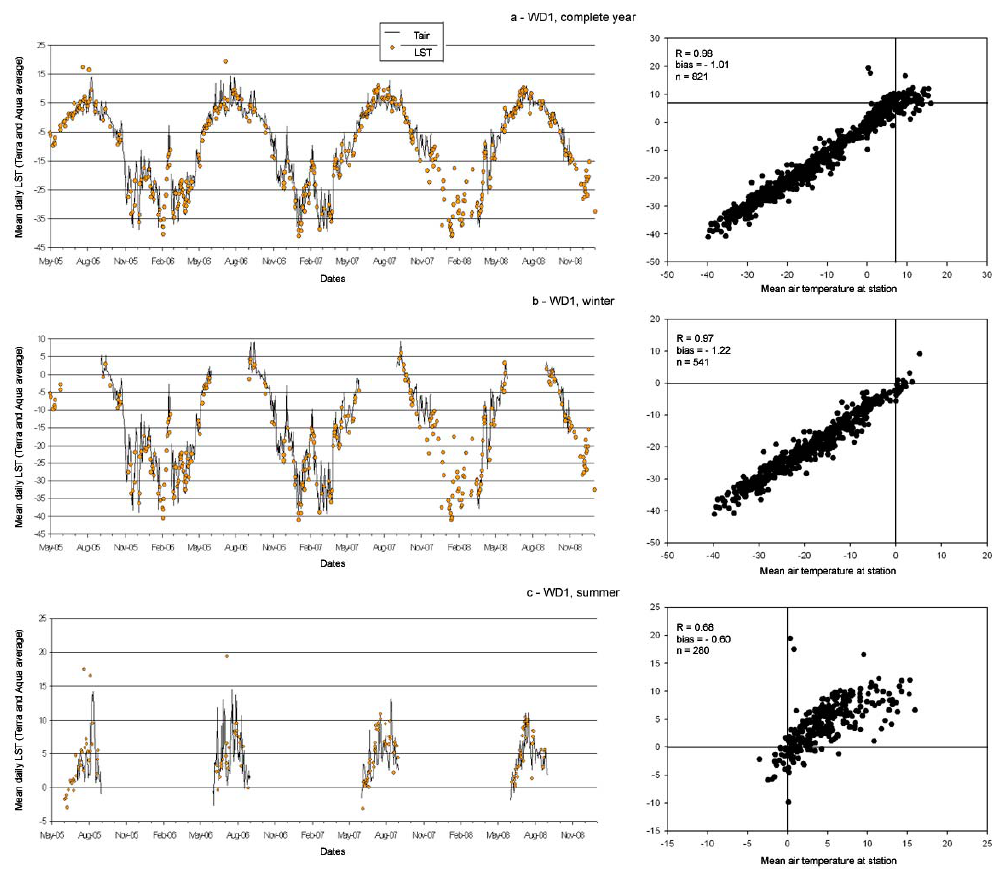
Fig. 5.Comparison between the mean daily LST (combined Day/Night/Terra/Aqua) and mean daily air temperature at West Dock (WD1) for (a) complete year, (b) winter, and (c) summer. On left, LST overlayed on meteorological station measurements, and on right relation between the two sets of measurements.